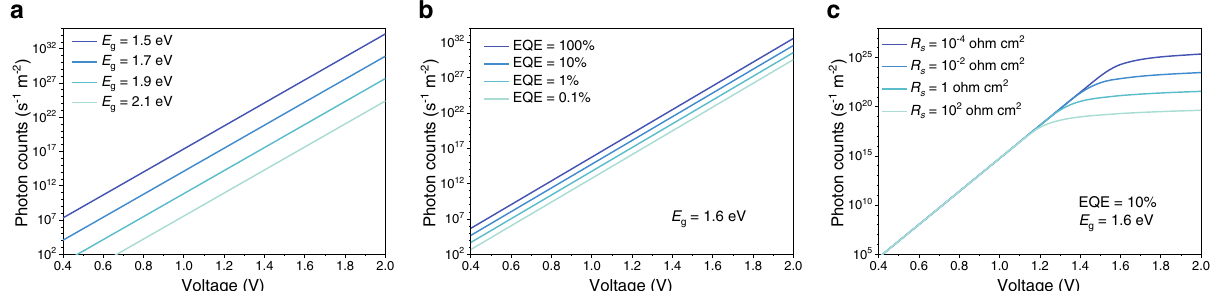
Fig. 5 EL intensity-voltage curves generated by a simple LED model. a Effect of bandgap. Ideal diodes with zero series resistance and an EQE of unity are assumed. b Effect of EQE. A bandgap of 1.6 eV with zero series resistance is assumed. c Effect of series resistance. A bandgap of 1.6 eV and an EQE of 10% are